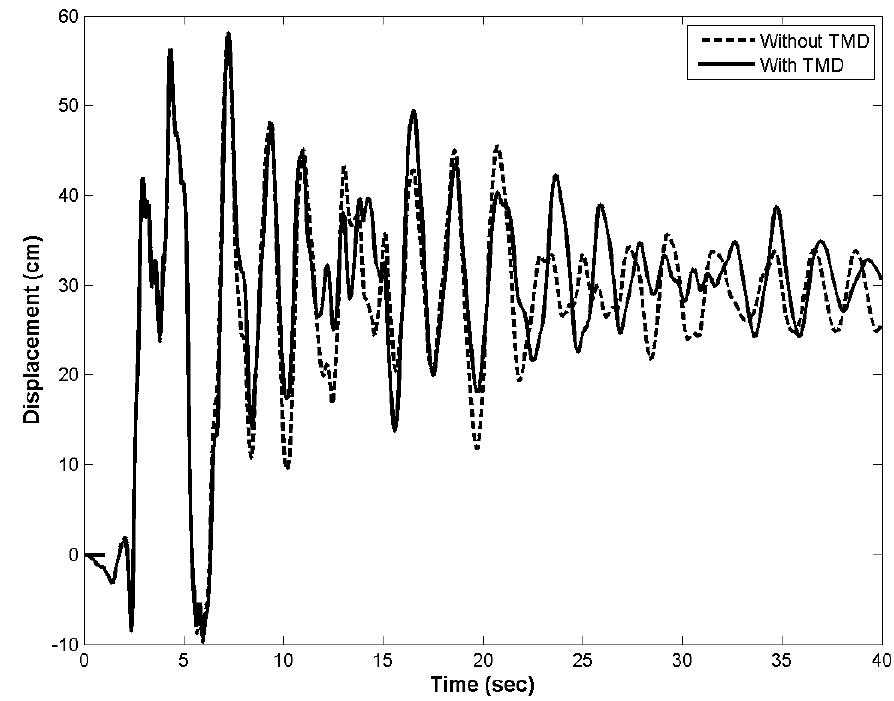
Fig. 9. Displacement Results for the Roof of a First Floor Irregular Structure Subjected to the Loma Prieta Earthquake (PGA =